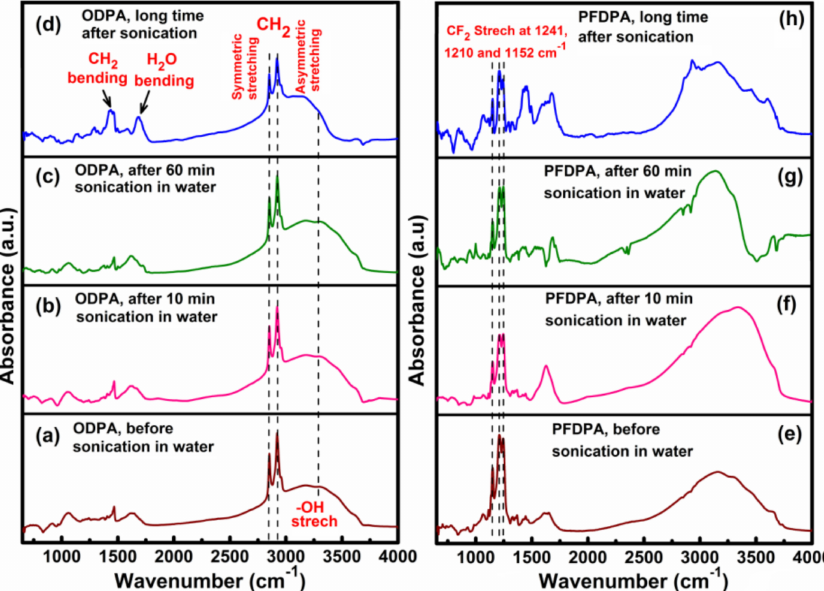
Figure 5. Diffuse reflectance Fourier transform infrared spectroscopy (DRIFTS) spectra of the as-prepared TNTAs functionalized with ODPA and PFDPA and after ultrasonication in